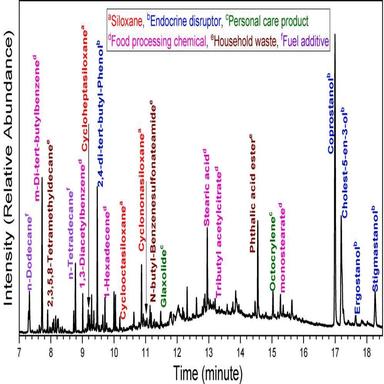
Gas chromatogram of foulants recovered from the first-stage element and tentative chemical identification based on mass spectrometry. Peaks are classified into broad chemical categories including siloxanes (red), endocrine disruptors (blue), personal care products (green), food processing (magenta), household wastes (brown), and fuel additives (purple). (For interpretation of the references to color in this figure legend, the reader is referred to the Web version of this article.)